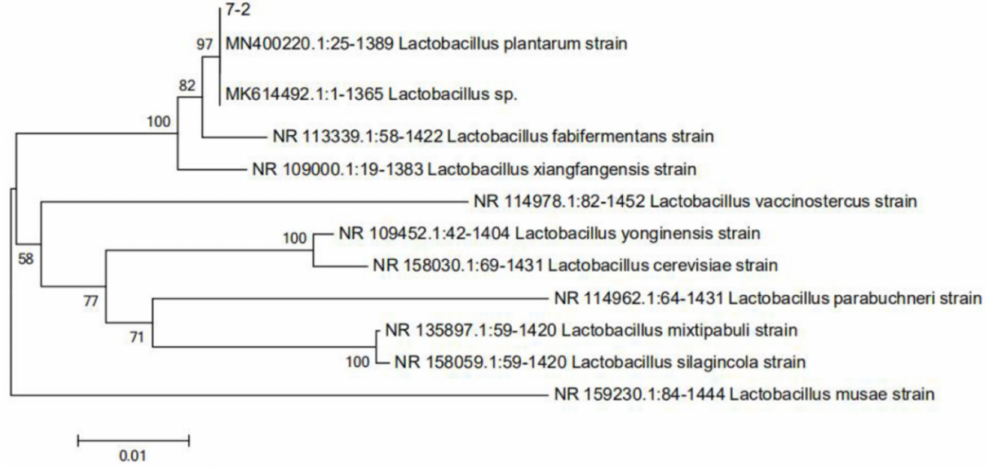
Figure 2. Phylogenetic tree of strain 7-2.